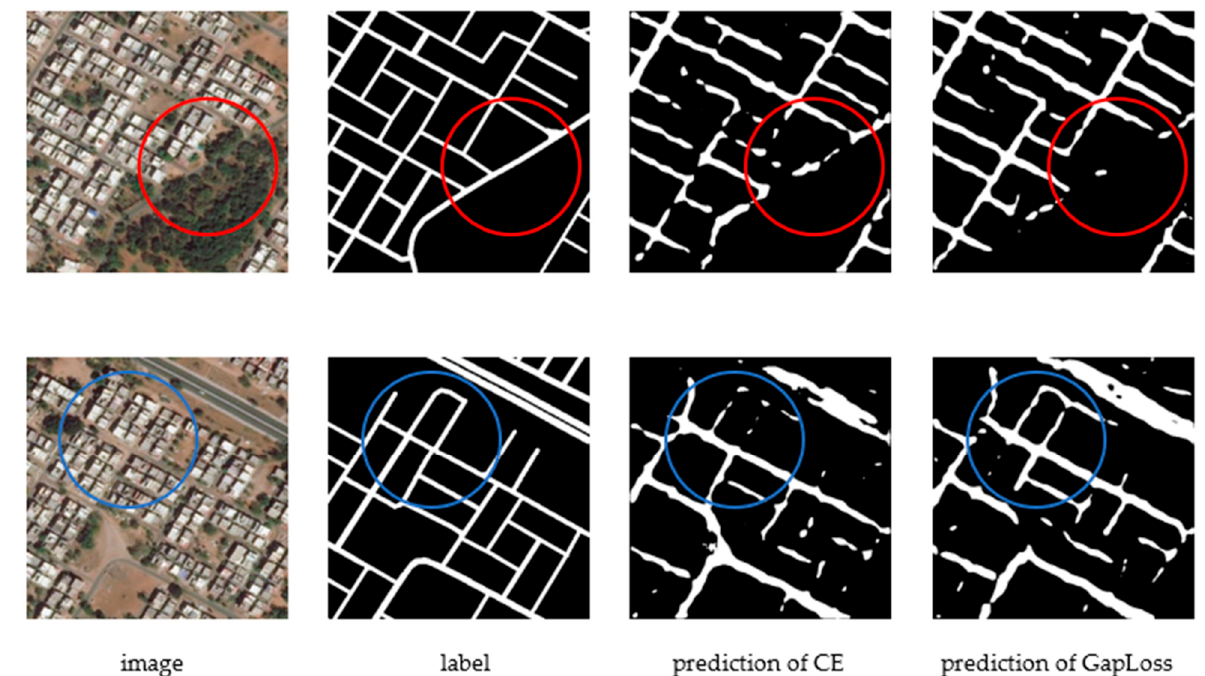
Figure 6. SegNet results with CE and GapLoss on DeepGlobe Roads Dataset. The blue and red circles indicate where the road continuity is improved after using GapLoss.